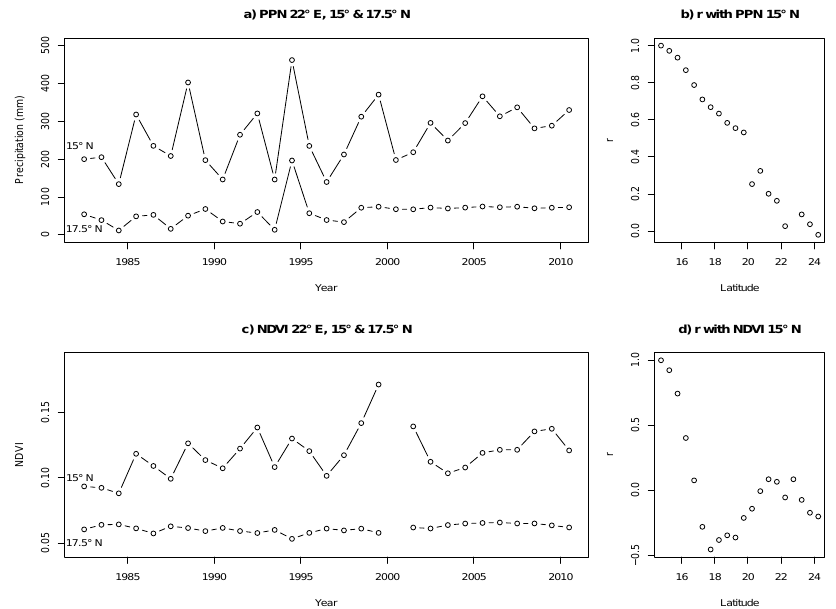
Figure 7. (a) Time series of annual precipitation for 15.25 ◦ N and 22.25 ◦ E and for 17.75 ◦ N and 22.25 ◦ E indicating a large degree of spatial correlation in precipitation across the Sahel (transition from savannah to desert south of the Sahara). (b) Correlation between annual precipitation at 15.25 ◦ N and 22.25 ◦ E and time series from 15.25 to 24.25 ◦ N; spatial correlation slowly decreases from 1 to 0 over a distance of approximately 780km. (c) Same as (a) but for mean annual vegetation index time series. (d) Same as (b) but for annual vegetation index time series. The correlation between NDVI time series decreases to zero over a distance of only 280km as opposed to 780km for